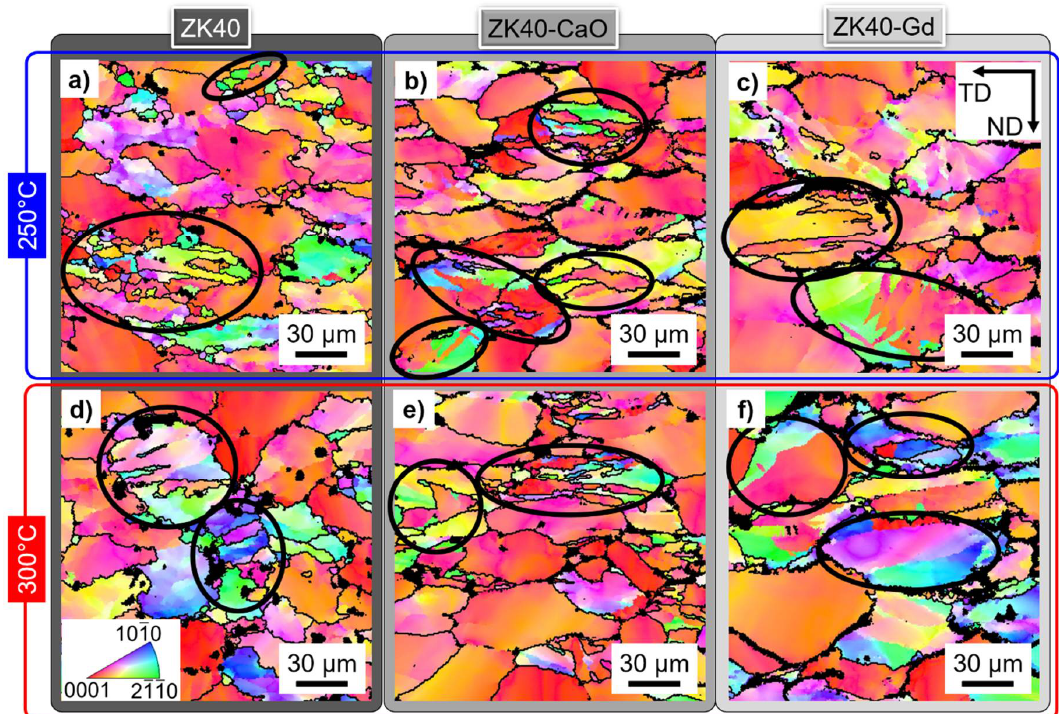
Figure 11. Inverse pole figure maps for the deformed alloys at 0.001 s − 1 : ( a , d ) ZK40; ( b , e ) ZK40-CaO; ( c , f ) ZK40-Gd; and: ( a – c ) 250 °C, ( d – f ) 300 °C. Only α-Mg is indexed. Non-indexed regions are highly deformed regions or intermetallic compounds. Black lines indicate high angle grain boundaries. Black ellipses indicate regions that resemble twins. ND and TD indicate the compression and transversal directions, respectively.